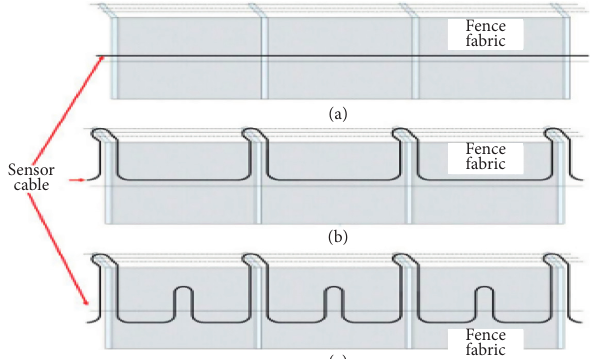
Figure 4: Example of different cable configurations on a chain link